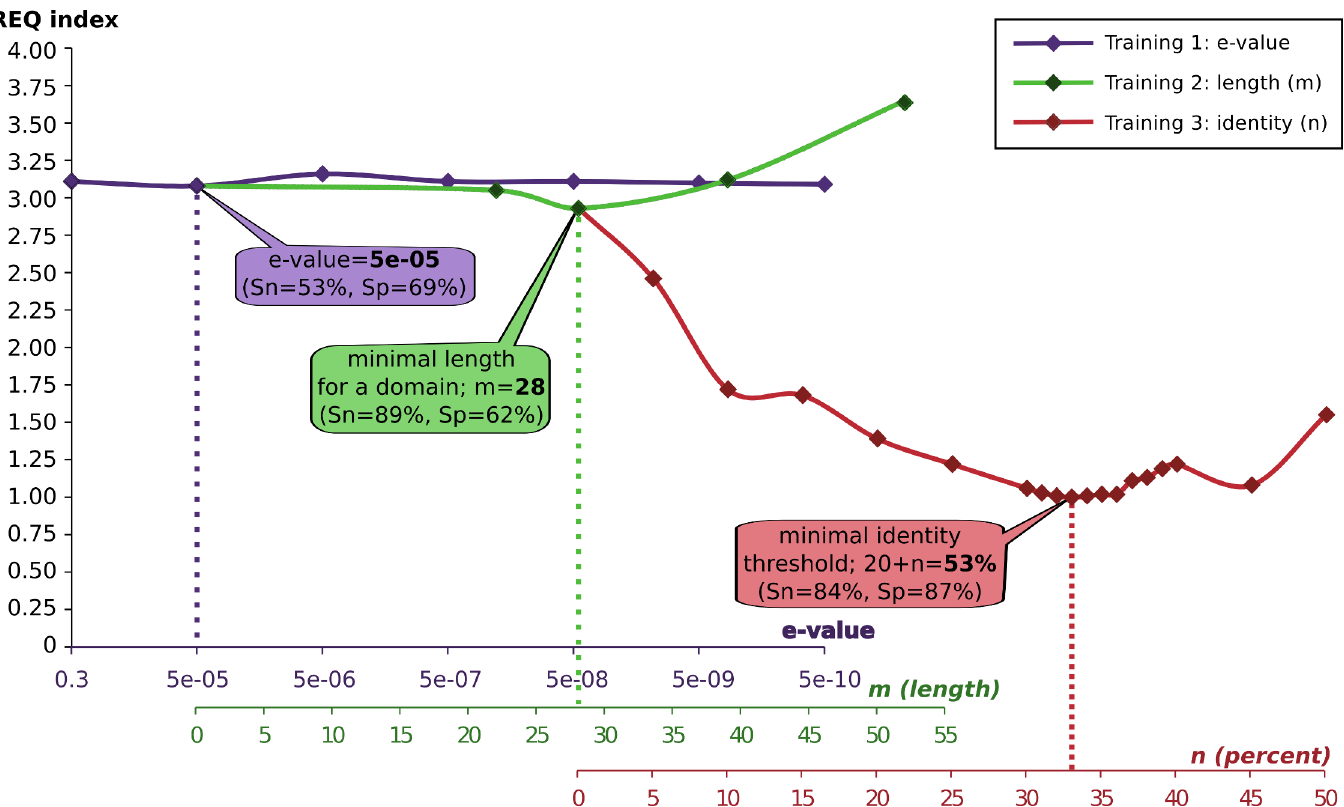
Fig 2. Accuracy measurement in the optimization of the orthoFind parameters. Different executions were carried out using a range of e-values (x-axis), m = 0, and n = 0. Then, the e-value was fixed to the value with the lowest REQ (dotted vertical lines), and new executions were carried out to fix the optimal length domain ( m ). Finally, the procedure was repeated with the identity ( n in Rost curve). Values of sensitivity (Sn) and specificity (Sp) are shown on the balloons, which represent the points with lowest REQ and therefore with the best